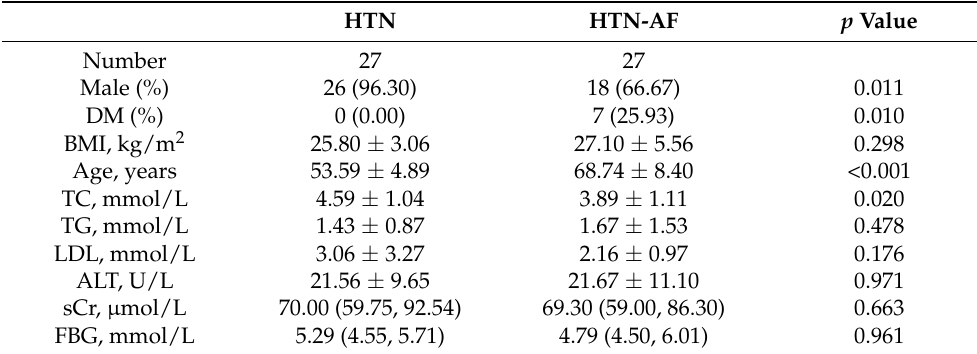
Table 1. Baseline clinical characteristics of the HTN patients with or without